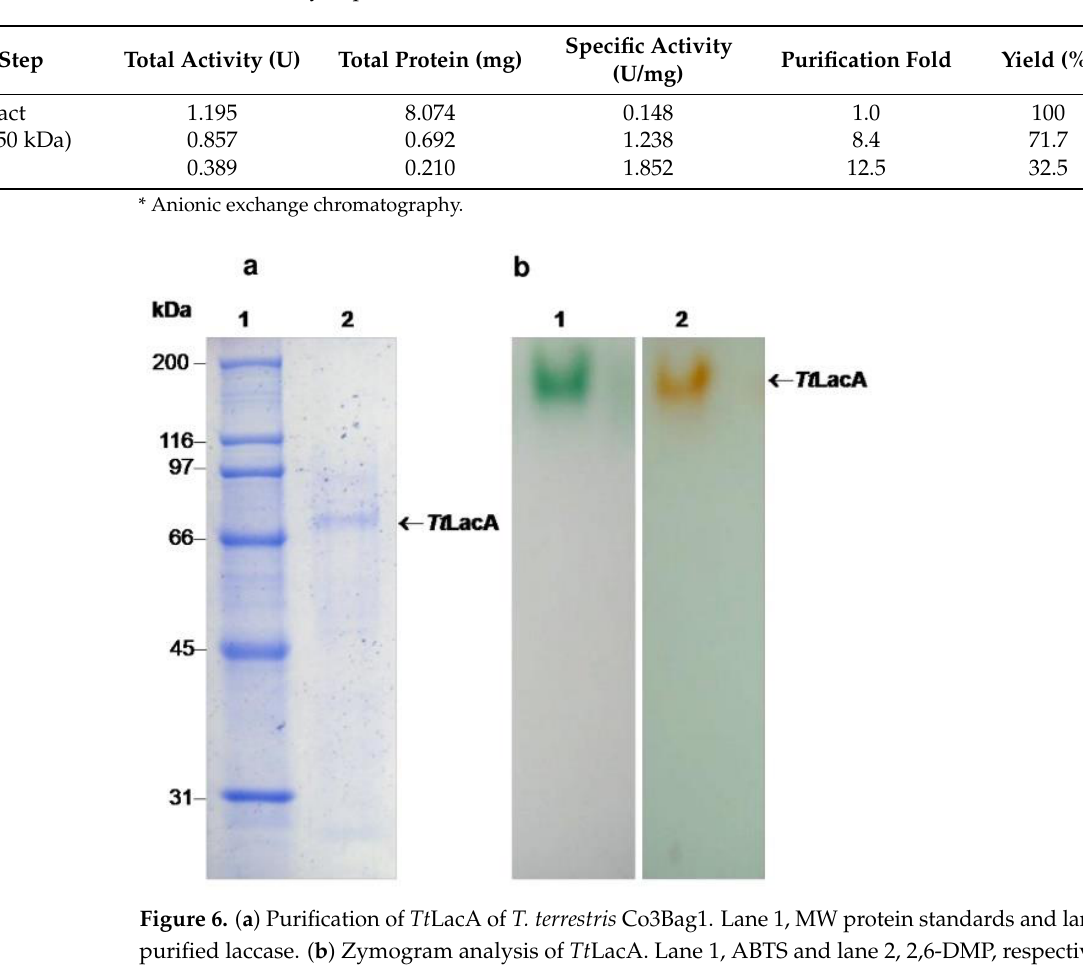
Table 1. Summary of purification of Tt LacA.